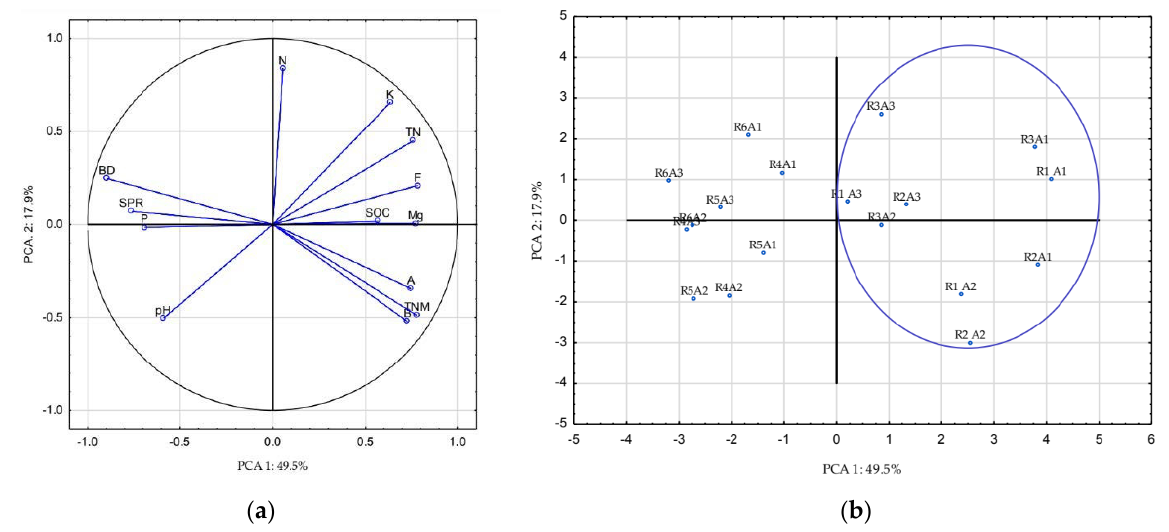
Figure 5. Principal component analysis derived from the studied soil properties. ( a ) PCA analysis (principal component analysis PC1, PC2) of soil properties: BD, SPR, SOC, TN,N, pH, P, K, Mg, B, A, F, TMN; ( b ) projection of the cases on the factor-plane — principal component analysis of the